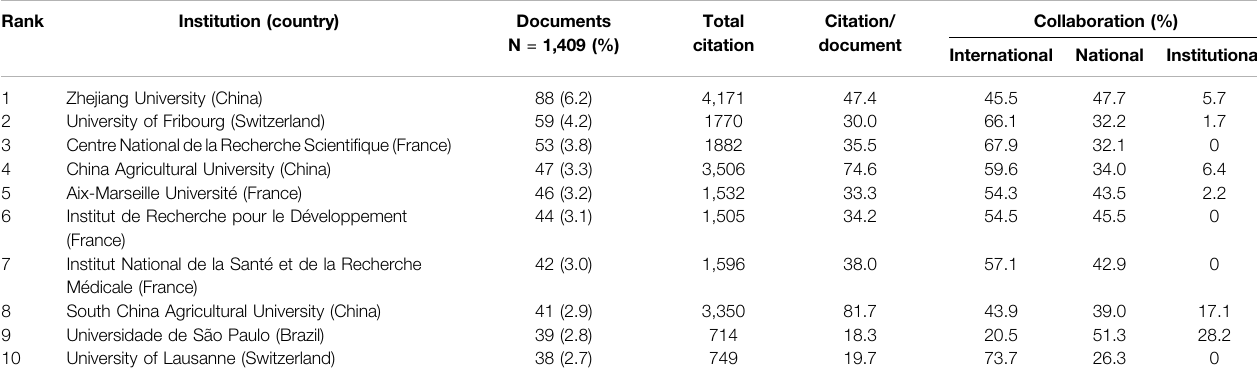
TABLE 4 | Top ten productive institutions on polymyxin resistance (2010 –